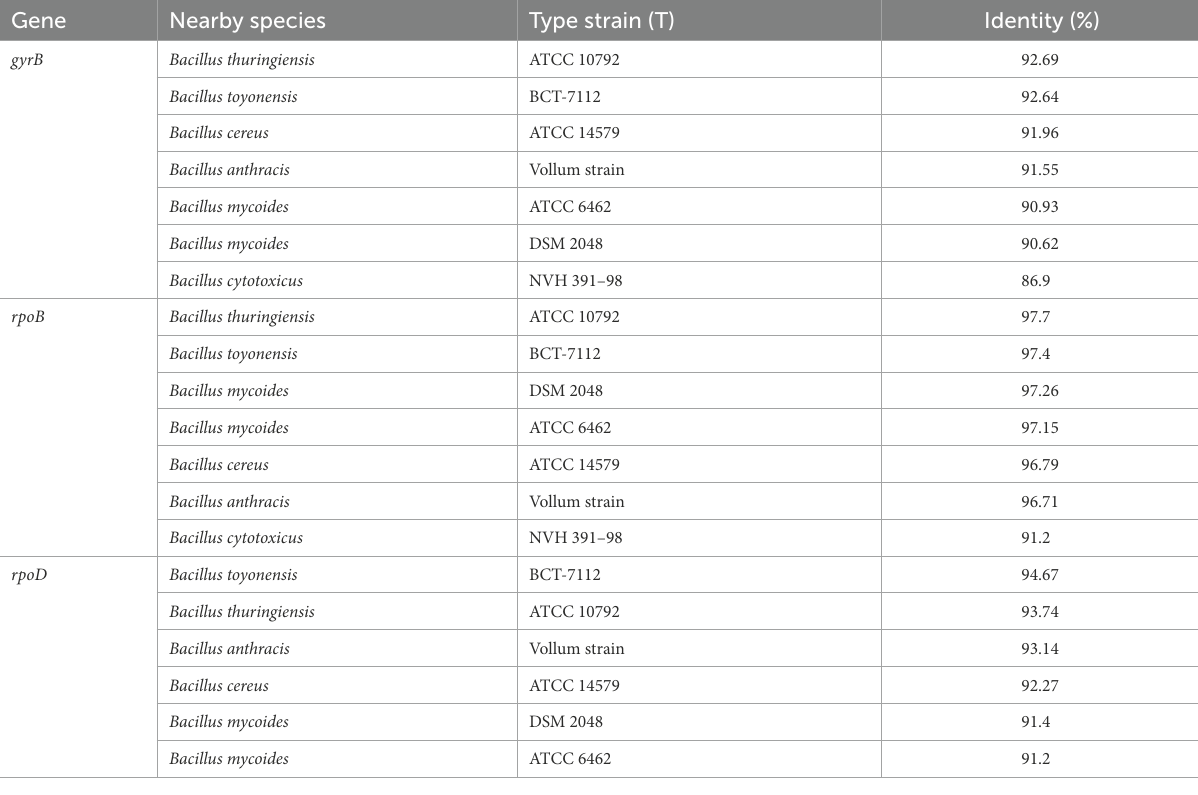
TABLE 6A Similarity of the gyrB, rpoB , and rpoD genes of the taxa with valid names and SAICEU11 T . Gene